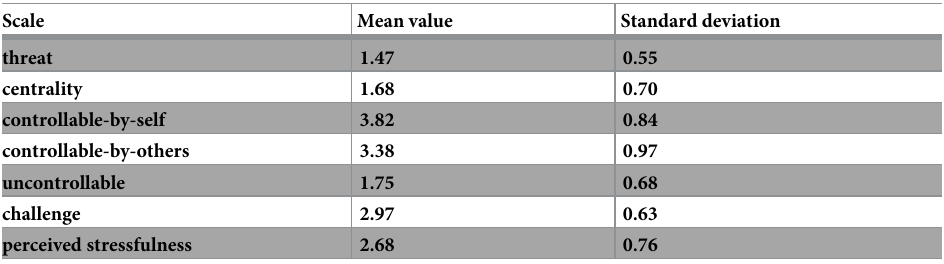
Table 4. SAM subscales-mean values and standard